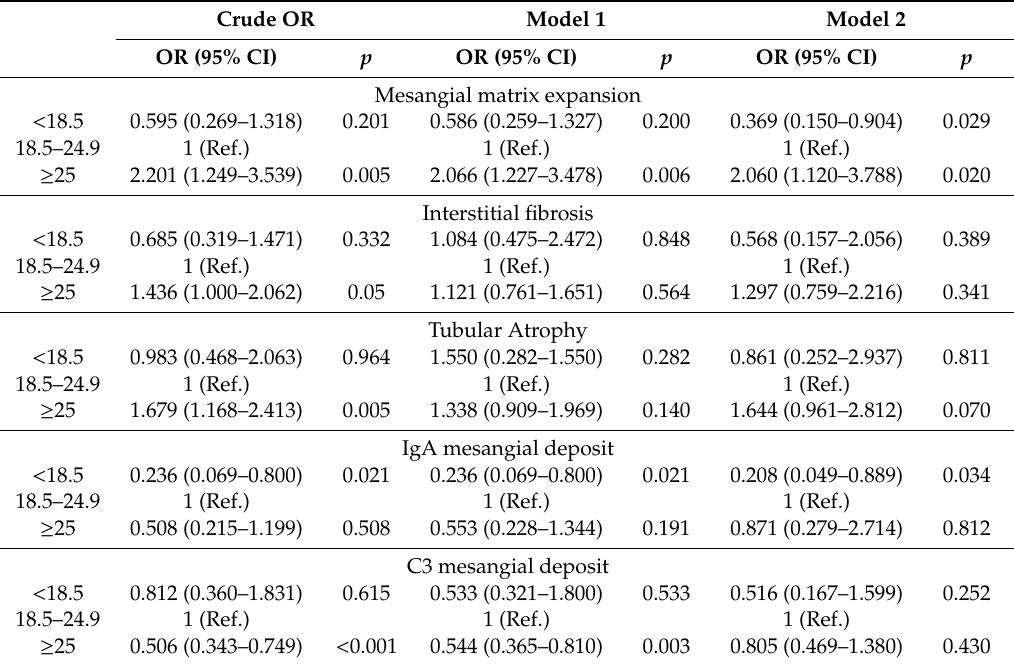
Table 5. Logistic regression analysis for BMI groups and histopathologic